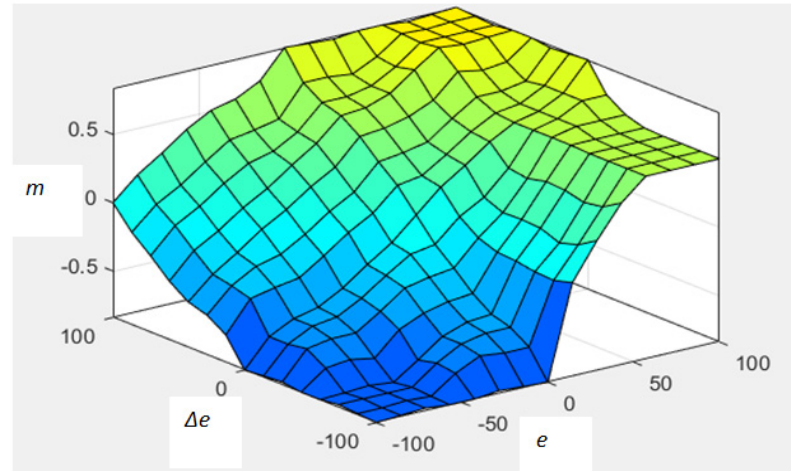
Figure 12. The control surface of fuzzy PI (e, Δ e vs.m).